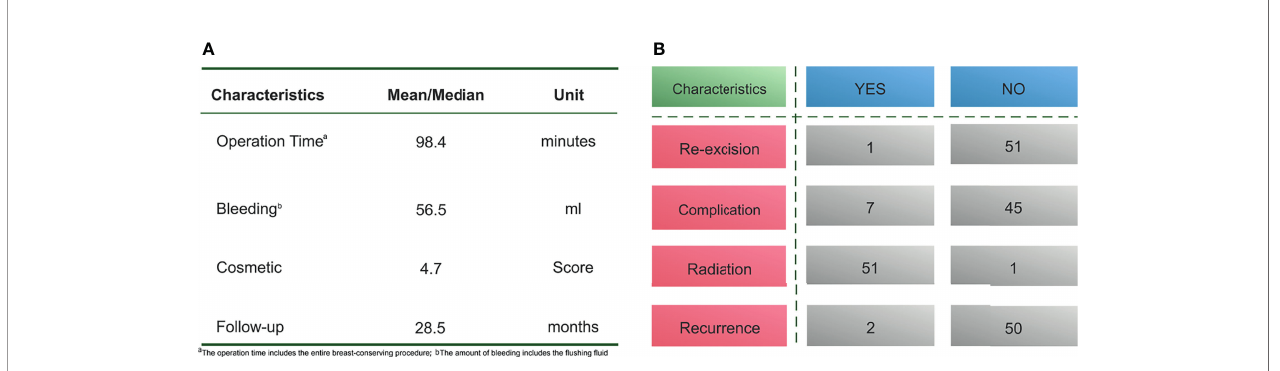
FIGURE 4 | Surgical information and complications of patients.